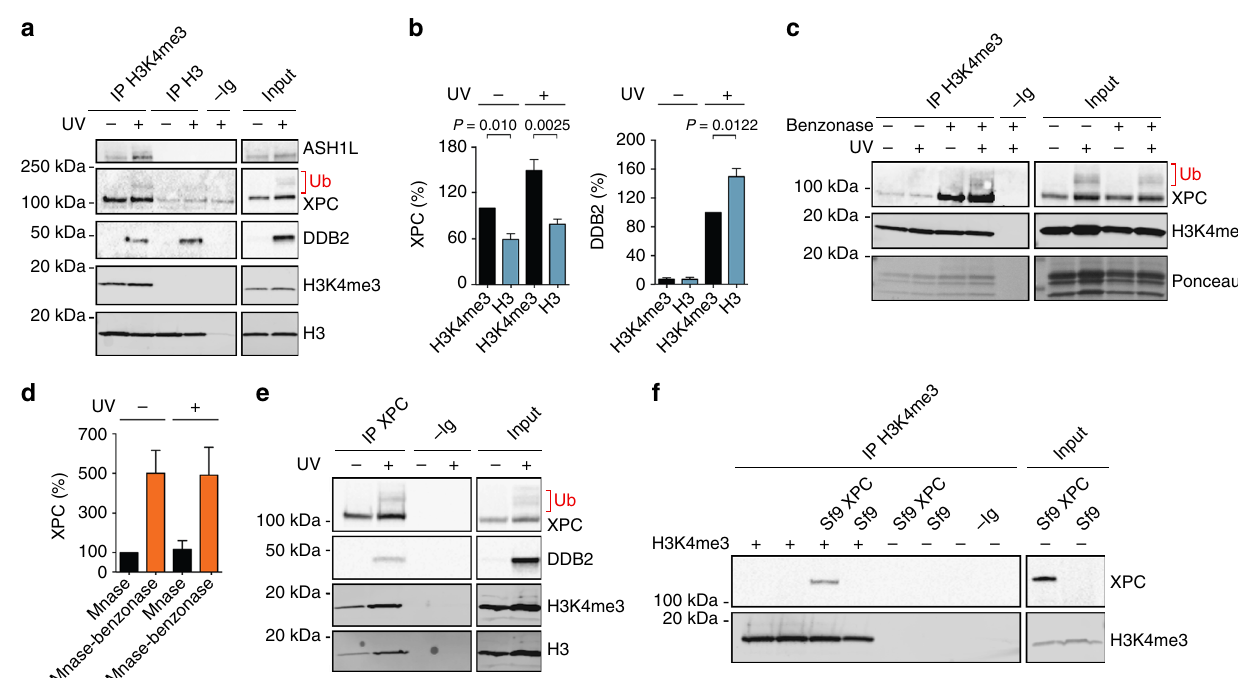
Fig. 7 Association of XPC with nucleosomes containing H3K4me3. a Interaction of XPC protein with core particles generated by MNase digestion of chromatin. These core particles were immunoprecipitated with anti-H3 or anti-H3K4me3 antibodies and analyzed by immunoblotting; – Ig, immunoglobulins omitted (core particles from UV-irradiated cells subjected to the same procedure except that antibodies were left out). b Quanti fi cation of XPC associating with core particles precipitated with anti-H3 or anti-H3K4me3 antibodies. The UV dose was 10 J m – 2 ; error bars show s.e.m, ( n = 3, one-sample t-test with a hypothetical value of 100). c Interaction of XPC protein with histone octamers generated by MNase and benzonase digestion of chromatin. These octamers were immunoprecipitated with anti-H3K4me3 antibodies and analyzed by immunoblotting; – Ig, immunoglobulins omitted. Histones were stained with the Ponceau dye. d Quanti fi cation of XPC associating with histone octamers precipitated with anti-H3K4me3 antibodies ( n = 3, one-sample t-test). XPC levels in the unirradiated controls are set to 100%. e Histone octamers obtained by MNase and benzonase digestion of chromatin were immunoprecipitated with anti-XPC antibodies; – Ig, immunoglobulins omitted. f Interaction between recombinant XPC and H3K4me3. Lysates from sf9 cells expressing XPC protein were supplemented with H3K4me3 (2 µ g) as indicated and immunoprecipitated using anti-H3K4me3